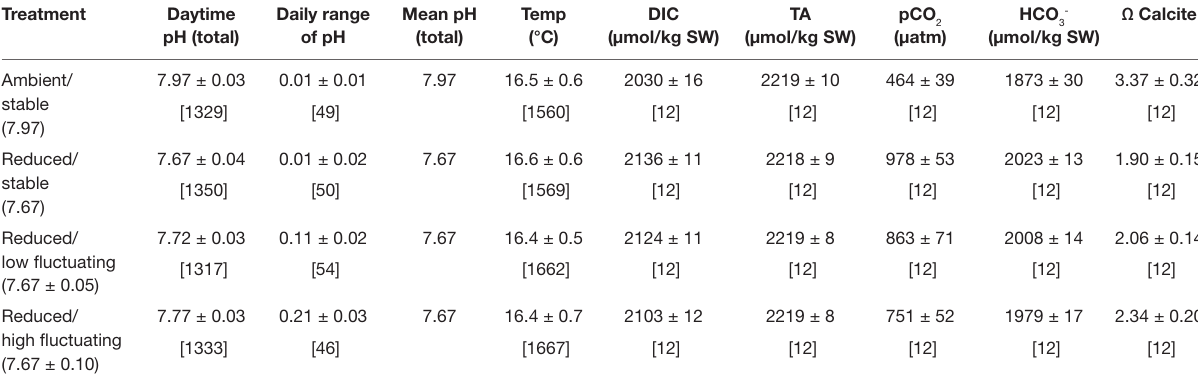
TABLE 1 Water parameters during the experimental period as mean ±